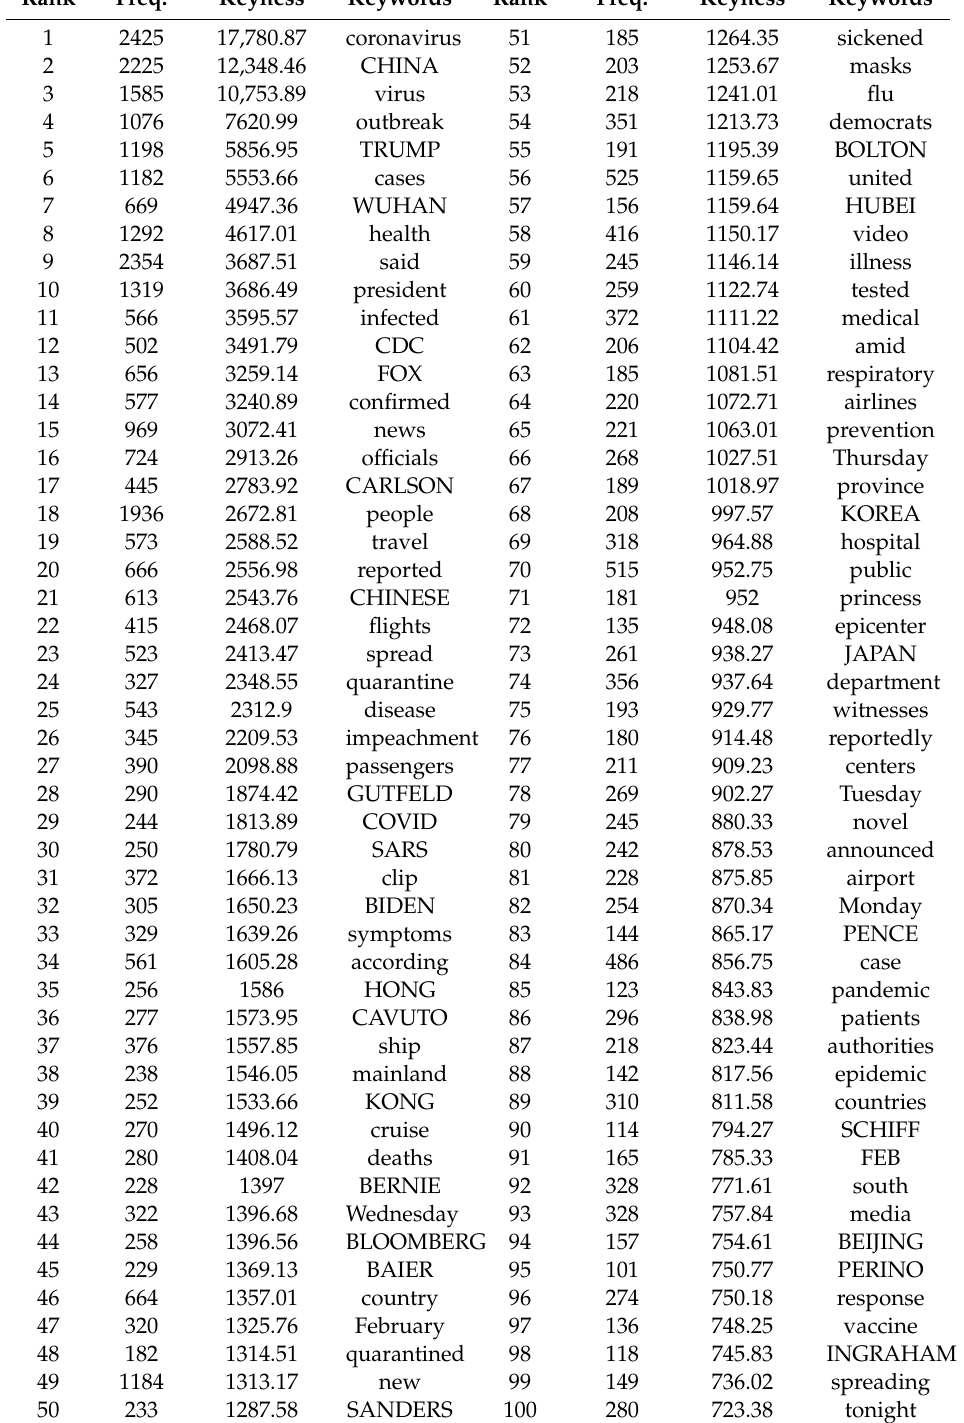
Table 6. An example of the refined keyword list from the target corpora (partial